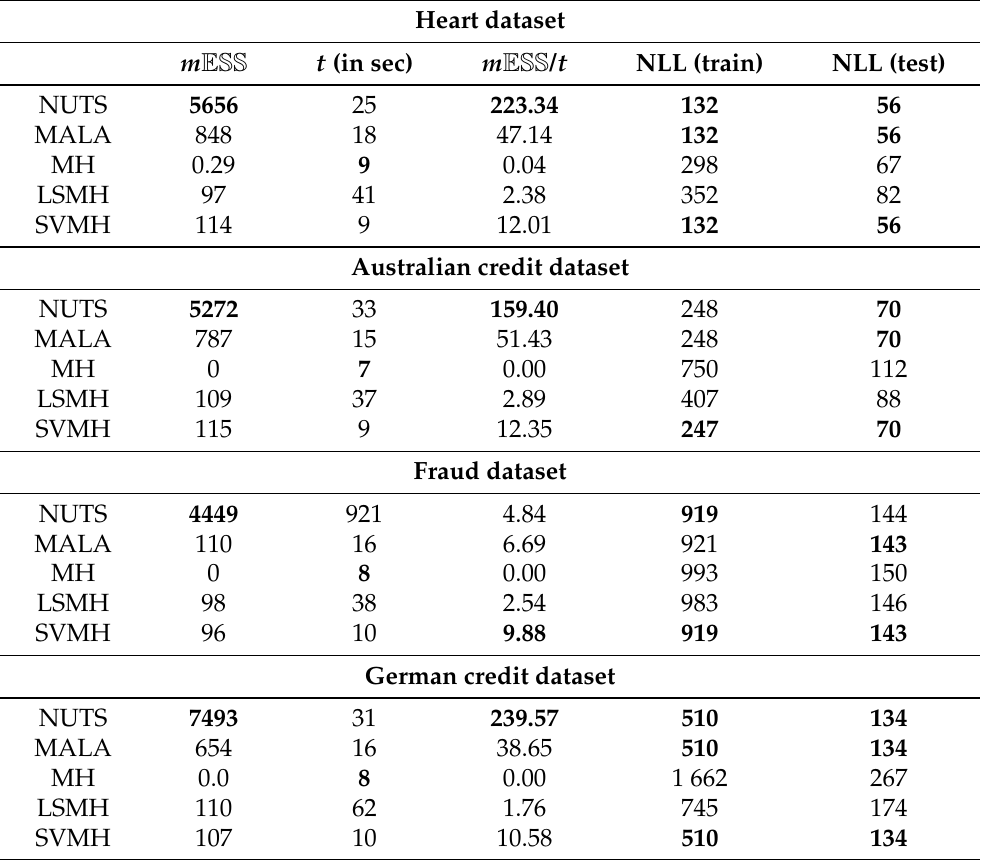
Table 4. Results averaged over thirty runs of each method for the logistic regression datasets. Each row corresponds to the results for a specific method for each performance metric. NLL is the negative